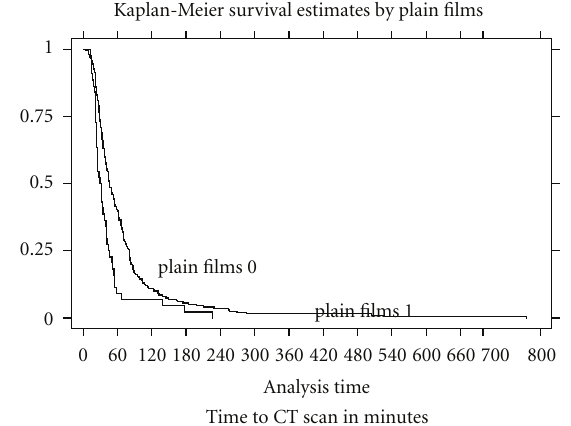
Figure 1: Kaplan-Meier plot showing time to CT if plain films were performed or